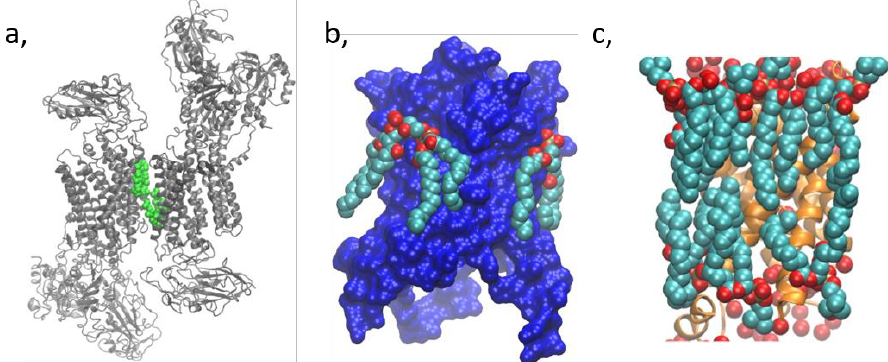
Figure 3. X-ray crystal structures of: ( a ) The porcine Na + /K + ATPase (grey) with bound cholesterol molecules (green), most certainly as non-annular lipids; ( b ) the bovine ADP/ATP carrier (blue) with annular-bound diphosphatidylglycerol molecules (cyan); and ( c ) the lens aquaporin (orange) with several phosphatidylcholine (PC) molecules (in cyan) in a configuration approximating the bilayer. Those images were reproduced from [53] .